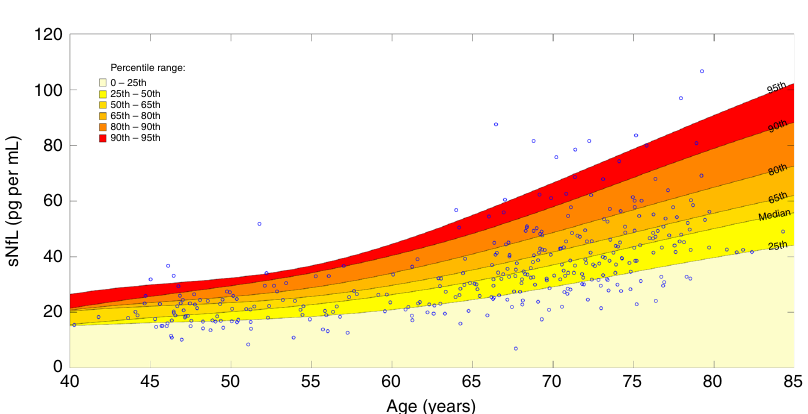
Fig. 1 Percentile ranges of sNfL. Percentile range areas of sNfL during the course of normal aging: The spline interpolated PCTL range curves are based on the sNfL measures in each age category (see Table 2 and Table 3). Source data are provided as a Source Data fi le.